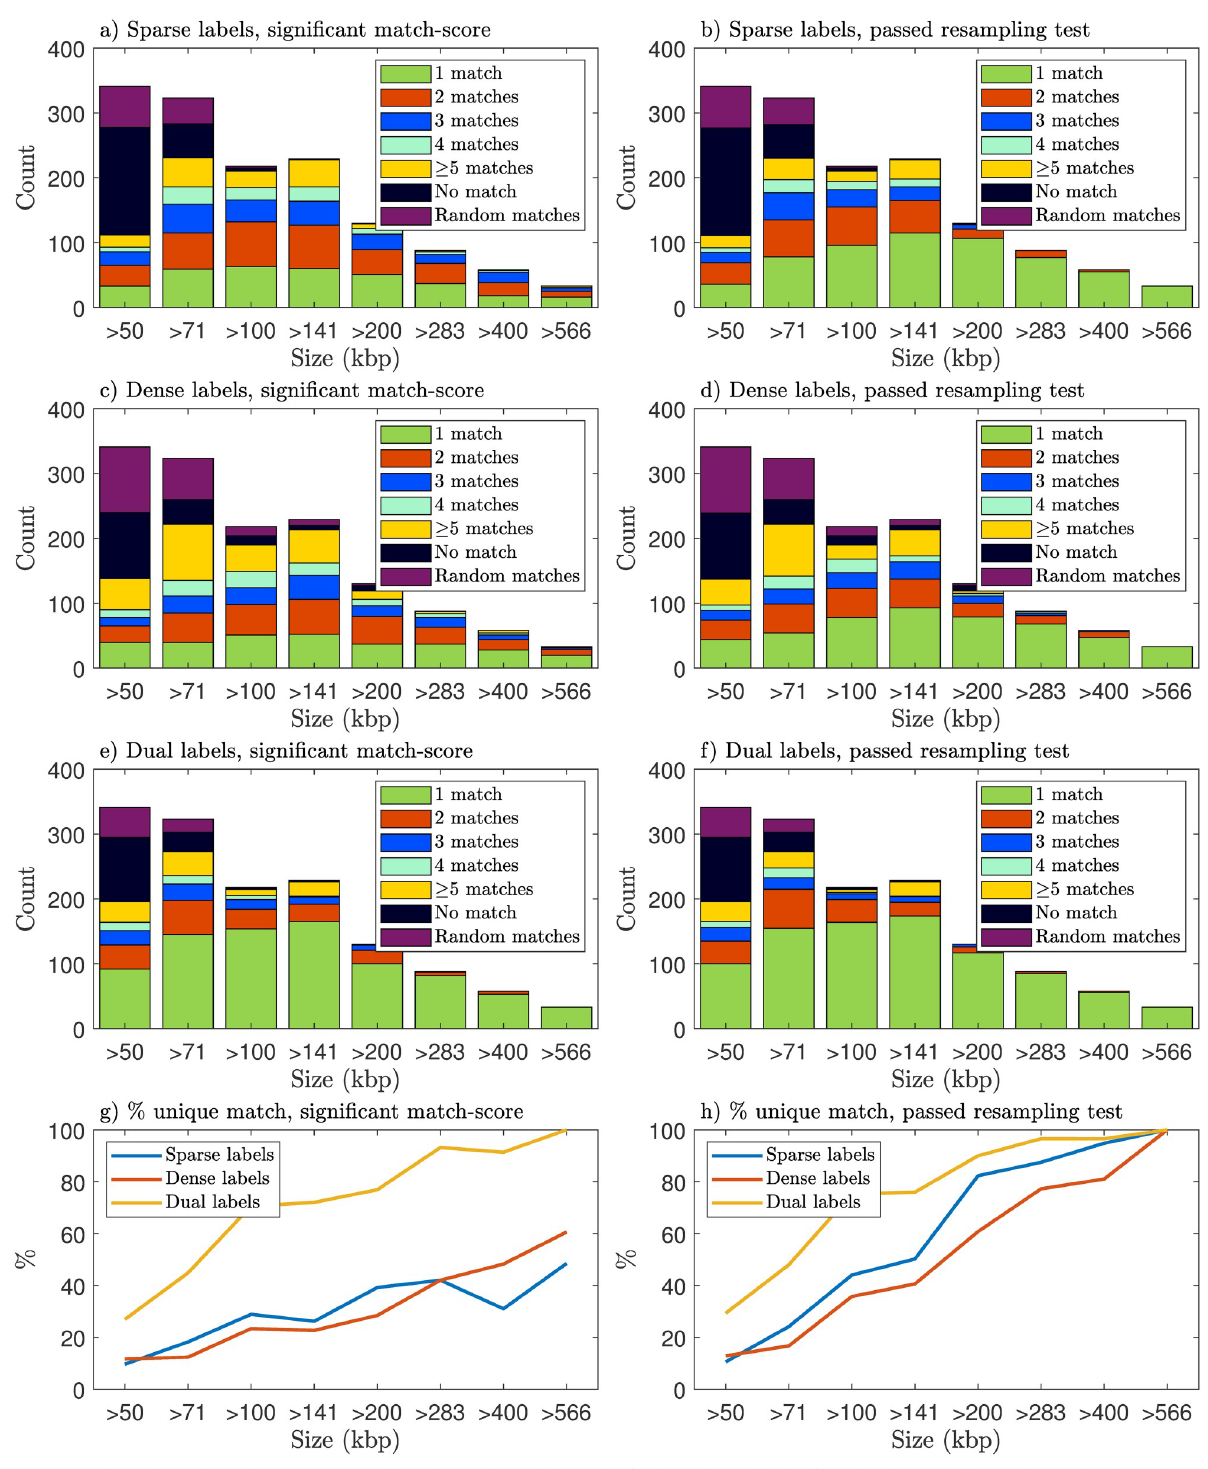
Fig 7. Number of matches when comparing all synthetic plasmid barcodes (nick- and CB-labeling) to the theoretical barcodes in the plasmid barcode database. For each plasmid in the database, the experiment for obtaining nick-labeled barcodes was emulated using the nicking enzyme BspQI. CB barcodes were obtained as described in Methods. The panels on the left show the number of matches with statistically significant match- scores, and the panels on the right show the number of best subset matches (passed the resampling test). The plasmids are sorted and binned by their lengths. ‘No match’ means that no database plasmid had a statistically significant match-score, and ‘Random matches’ means that matches were found,